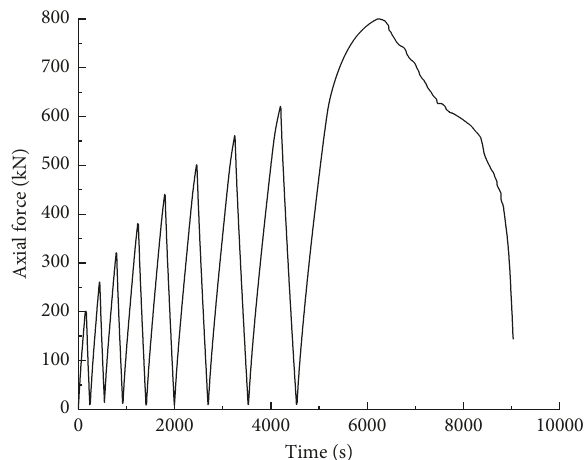
Figure 2: X-H-3 cyclic loading-unloading